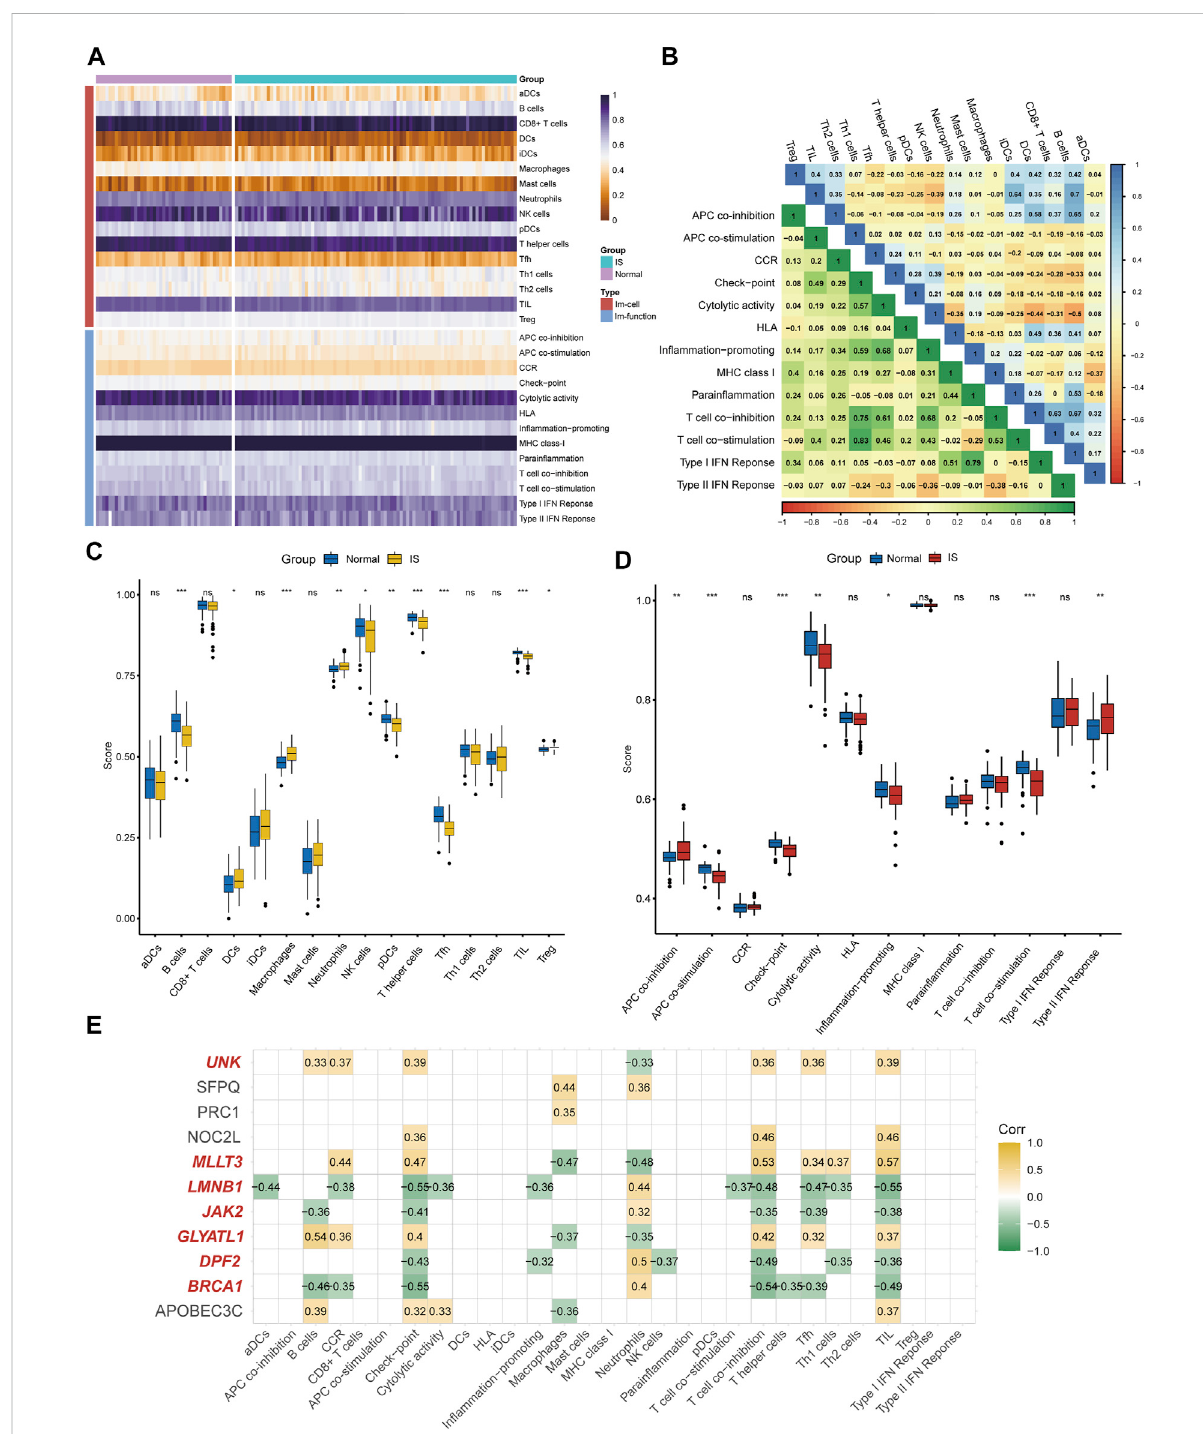
FIGURE 4 Immune in fi ltration analysis and immune biomarkers screening. (A) Immune in fi ltration heatmap in GSE58294 and GSE22255 dataset. (B) Correlation heatmap of immune cells and immune function. (C) The expression difference of 16 immune cells between IS and healthy samples. (D) the expression difference of 13 immune-related functions between IS and healthy samples (E) Screening for CRs-related immune